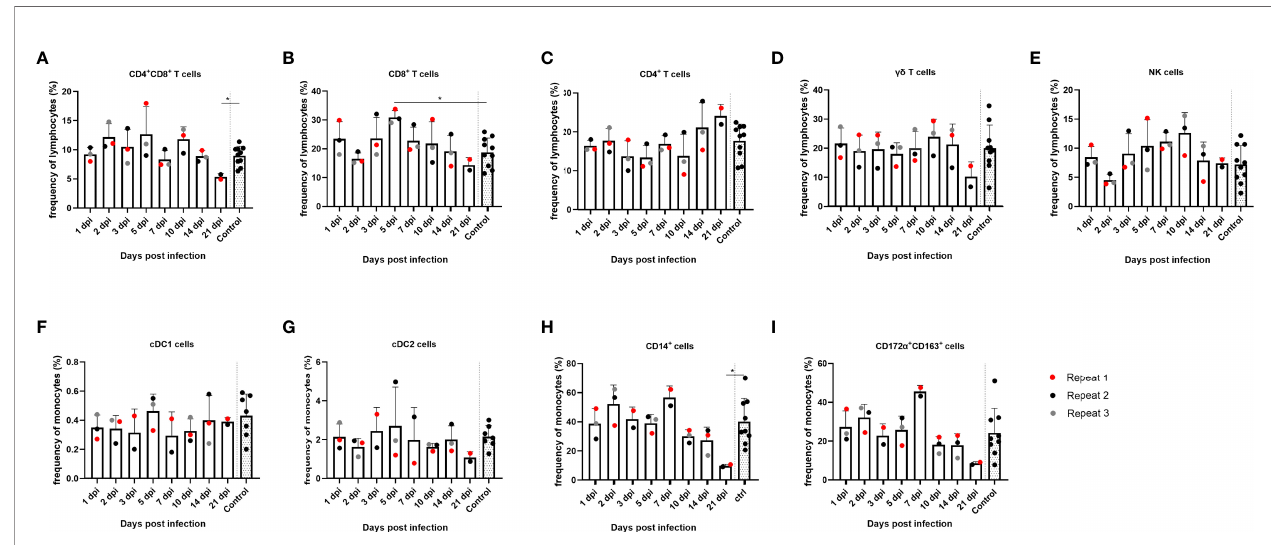
FIGURE 4 | Evolution of lymphocyte and monocyte frequencies in PBMCs of JEV-infected pigs. PBMCs from 9-week-old intradermally inoculated pigs with JEV were isolated and analyzed by fl ow cytometry. Mean frequencies of (A) CD4 + CD8 + double-positive T cells, (B) CD8 + T cells, (C) CD4 + T cells, (D) gd T cells, (E) NK cells, (F) cDC1 cells, (G) cDC2 cells, (H) CD14 + , and (I) CD172a + CD163 + are displayed as bars. Three animals were analyzed per time point, and each dot represents one animal and are expressed as the frequency of all lymphocytes for lymphocyte subsets or as the frequency of all monocytes for monocytic cell subsets. *Statistically signi fi cant different frequency compared to control